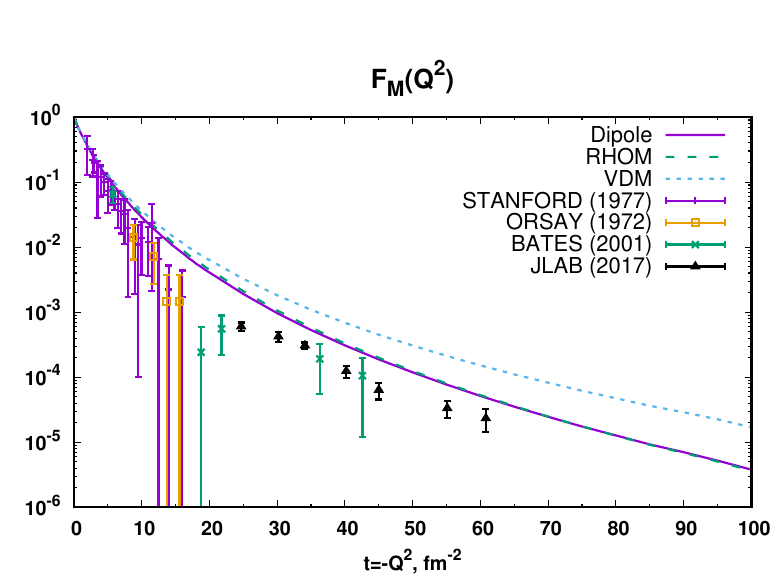
Figure 2. (Color online) The magnetic form factor of 3 He. Notations for the results as in Fig. 1. The experimental data STANFORD (1977) are from [17], ORSAY (1972) – [18], BATES (2001) –